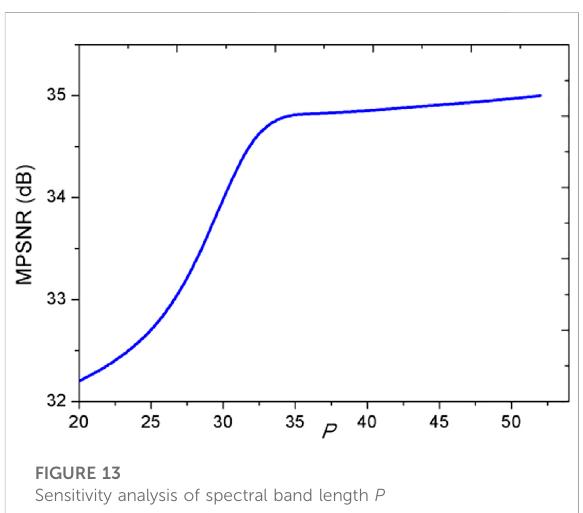
FIGURE 13 Sensitivity analysis of spectral band length